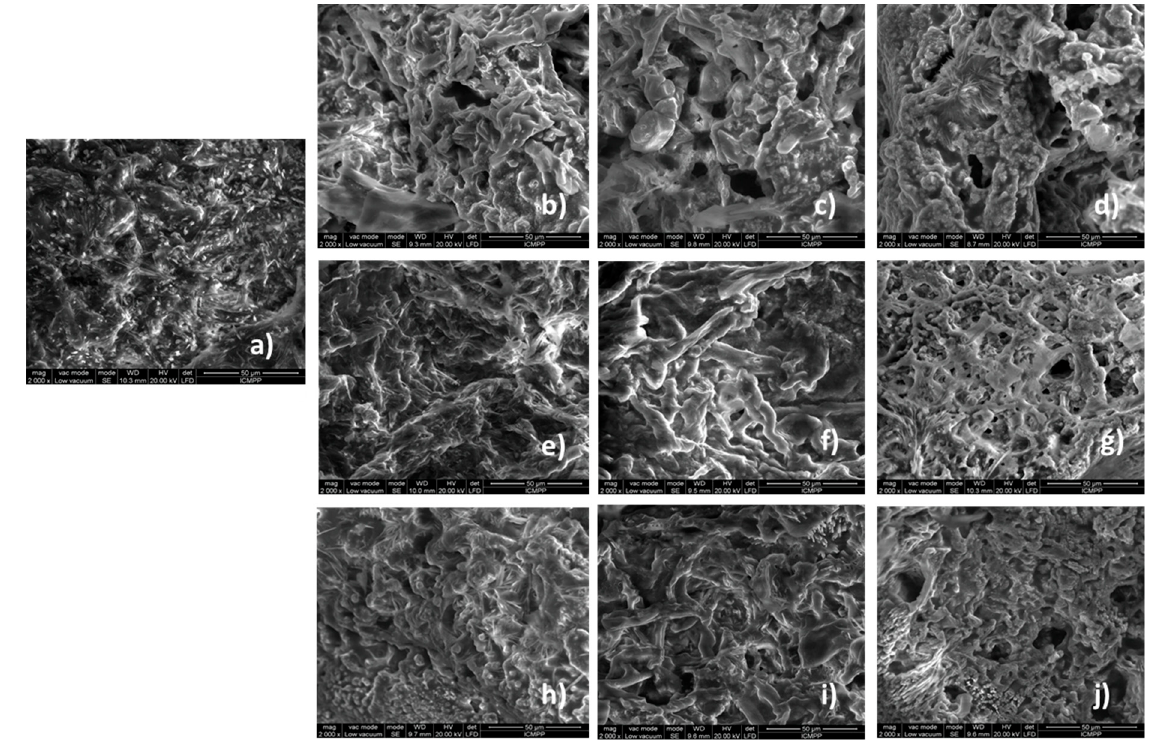
Figure 5. SEM microscopy of ( a ) Lys, ( b ) Lys_Ser_15_1, ( c ) Lys_Ser_5_1, ( d ) Lys_Ser_2_1, ( e ) Lys_Glu_15_1, ( f ) Lys_Glu_5_1, ( g ) Lys_Glu_2_1, ( h ) Lys_3Gly_15_1, ( i ) Lys_3Gly_5_1 and ( j ) Lys_3Gly_2_1.